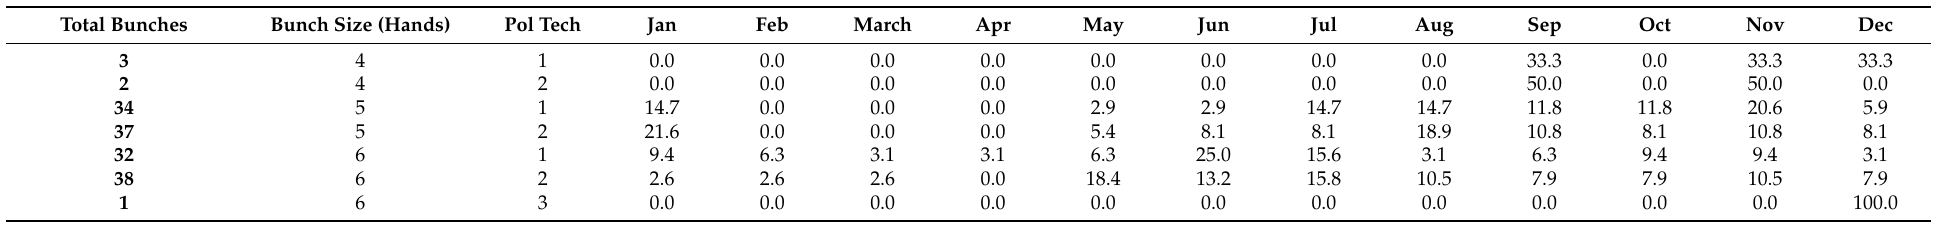
Table A6. Percentage bunch distribution by month of pollination in “Mshale” pollinated with “Calcutta 4”, using different pollination techniques, between January 2016 and January 2019. Total Bunches Bunch Size (Hands) Pol